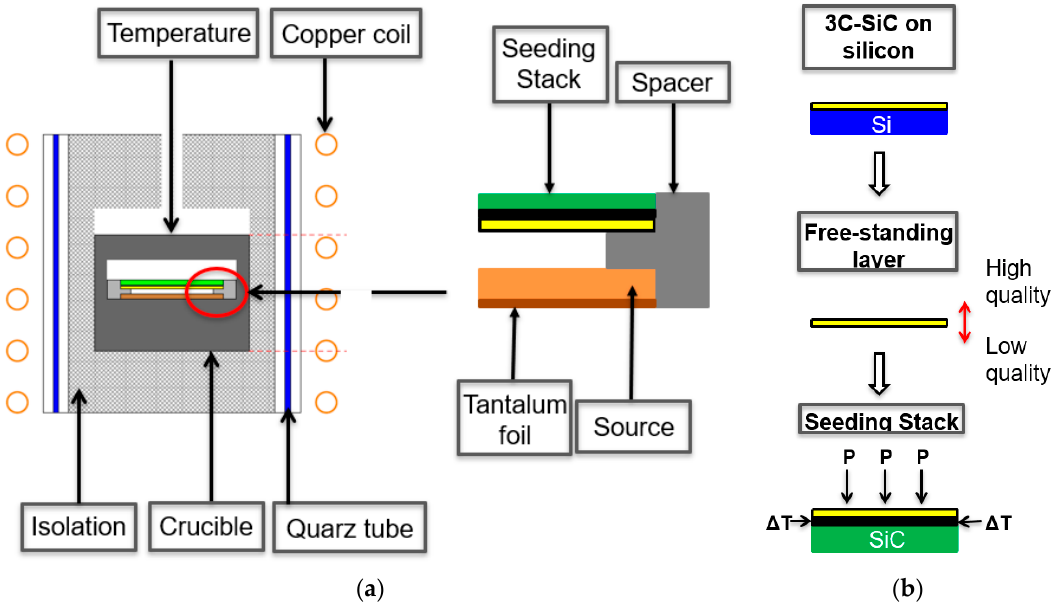
Figure 1. ( a ) Schematic of the used vertical physical vapor transport (PVT) reactor on the left and the hot zone on the right. Starting from the bottom of the hot zone, a tantalum foil is introduced as a carbon getter. On top, a polycrystalline SiC source is placed. The spacer limits the source-to-substrate distance. The final part is the self-manufactured seeding stack. ( b ) The manufacturing process for the seeding stack is necessary for high-temperature growth. The starting material is epitaxial 3C-SiC-on-Si grown by chemical vapor deposition (CVD). The removal of the silicon substrate is performed using wet-chemical etching by HNA (HF:HNO 3 :H 2 O) resulting in a high-quality growth front and a low-quality transition side. The final merging process is performed with a carbon glue layer (black), homogeneous pressure and a specific temperature treatment.